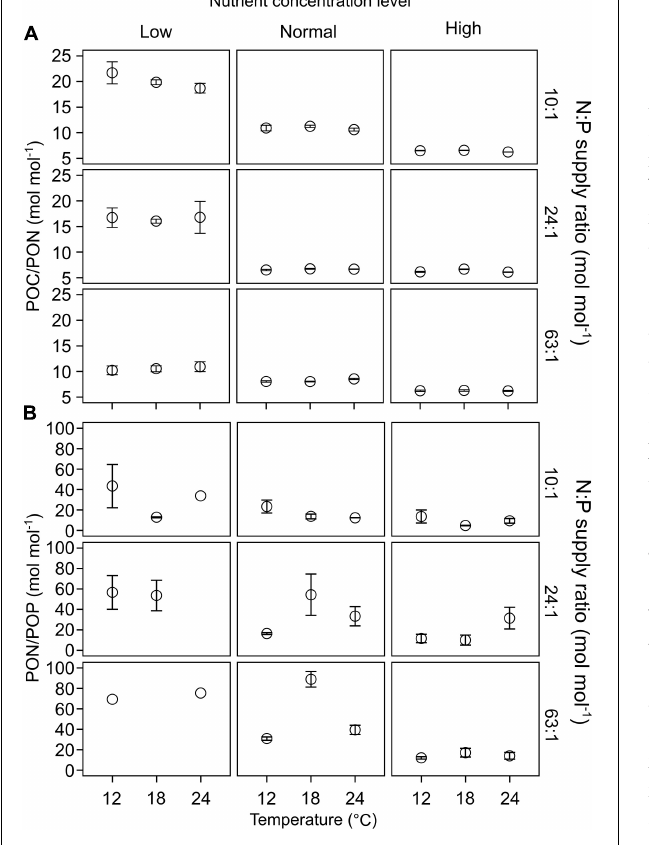
FIGURE 4 | The responses of C:N:P stoichiometry in particulate organic matters (mean ± SE) to temperature, N:P supply ratios and nutrient concentrations in the bicultures of Phaeodactylum tricornutum and Prorocentrum minimum : (A) POC/PON and (B)